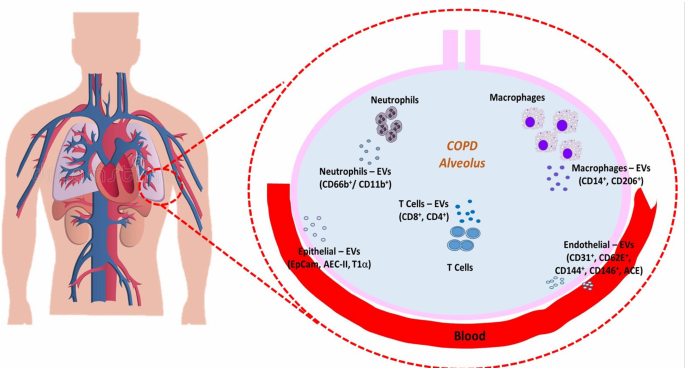
Figure 1. Summary of the EVs released from almost cell types in alveolar space and blood. EVs play a key cell-to-cell communicator role in the lung microenvironment and in the COPD